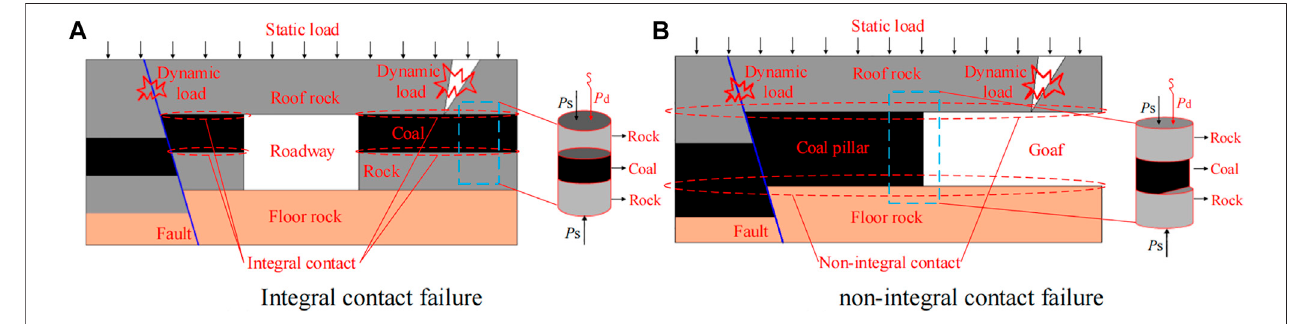
FIGURE 1 | Failure mode of coal-rock composite structure. (A) Integral contact failure; (B) Non-integral contact failure.